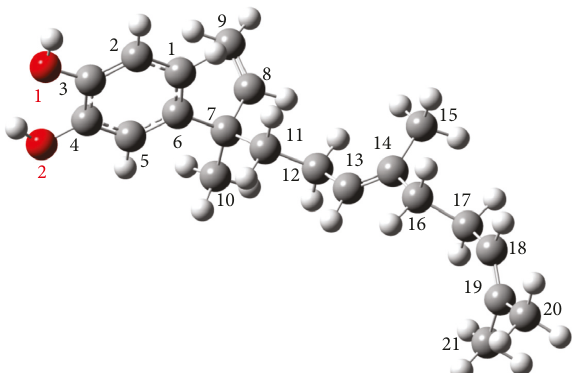
Figure 1: Optimized structure of the most stable conformation in the gas phase of 4-nerolidylcatechol (4NRC) with scheme of atom